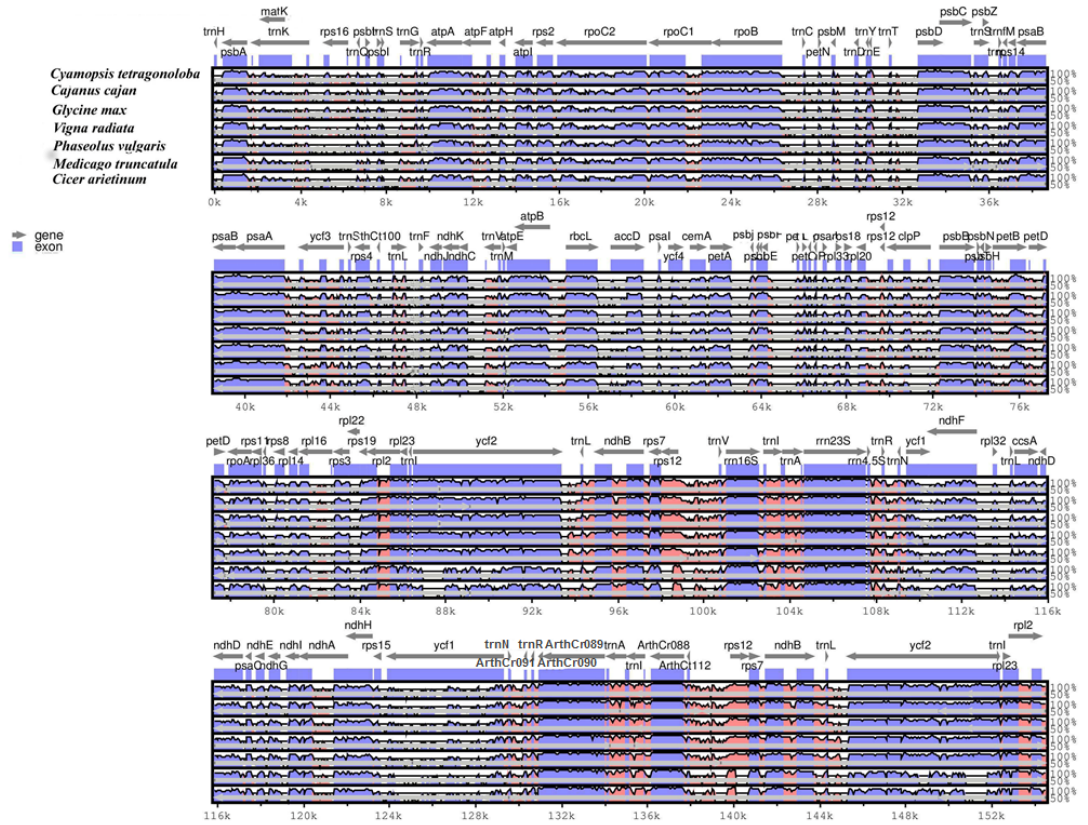
Figure 3. Sequence alignment of legume plastid genomes, with C. tetragonoloba Cp genome set as a reference using mVISTA. Position and transcriptional direction of each gene is indicated by gray arrows. Intergenic and genic regions are indicated by red and blue areas, respectively. Sequence identity between the Cp genomes is shown on y-axis as a percentage between 50% to